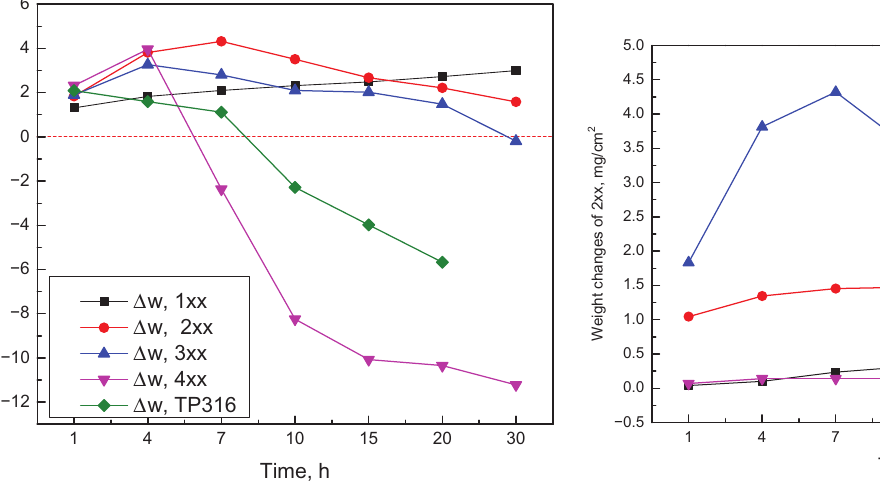
Figure 6: Weight changes during the corrosion process in different temperatures for 2xx